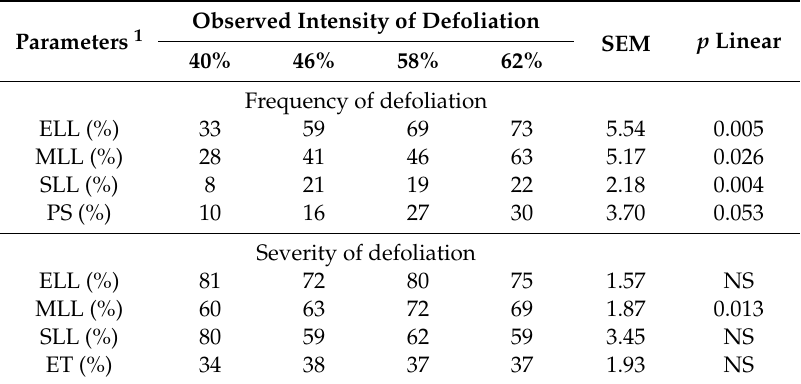
Table 2. Frequency and severity (in each bite event) of defoliation by leaf category, pseudostem, and extended tiller in kikuyugrass pastures subjected to di ff erent intensities of defoliation.